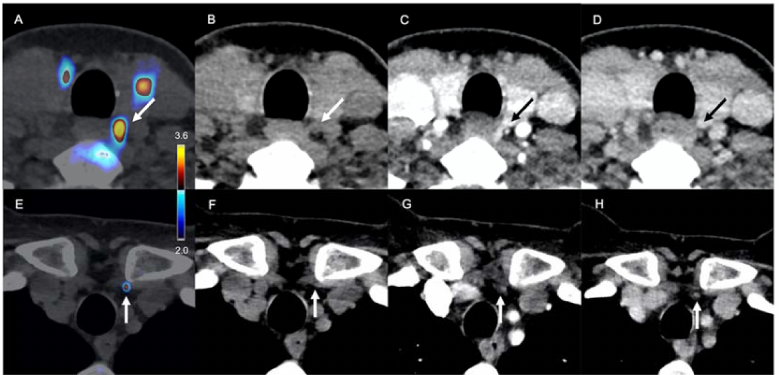
Figure 2. 18 F-FCH PET/CT and 4D-CT of a 56-year-old woman with recurrent pHPT and a history of upper and lower right parathyroidectomy (adenoma and hyperplasic gland, respectively). From left to right: fused PET/CT, non-contrast-enhanced CT, arterial-phase CT (30 s), venous-phase CT (70 s). Upper panel: lateral esophageal upper left adenoma (white and black arrows) with focal uptake of 18 F-FCH (SUVmax = 4) ( A ), spontaneous density of 66 HU ( B ), high enhancement at the arterial phase (137 HU) ( C ), and washout > 20 HU at the venous phase (102 HU) ( D ). Lower panel: hyperfunctioning parathyroid in the left thyrothymic ligament (white arrows) with focal uptake of 18 F-FCH (SUVmax = 3.2) ( E ), spontaneous density of 50 HU ( F ), no significant enhancement at the arterial phase (62 HU) ( G ) or venous phase (49 HU) ( H